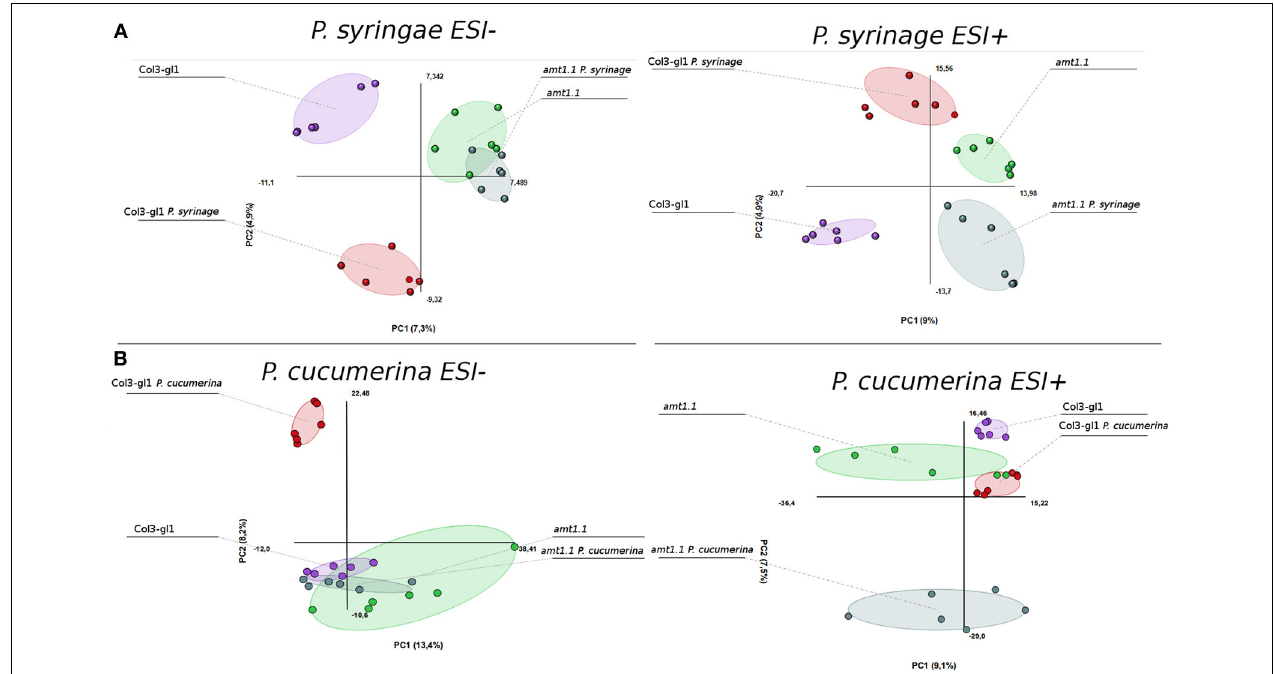
cucumerina and samples for analysis were collected 48hpi. Leaf material from 150 individual plants were pooled together for each treatment × genotype combination. Data points represent two technical replicates from three independent experiments (biological replicates; n = 6) injected randomly into the HPLC-QTOFMS. The signals corresponding to different treatments were compared using the non-parametric Kruskal-Wallis test, and only data with a P -value lower than 0.01 between groups was used for subsequent